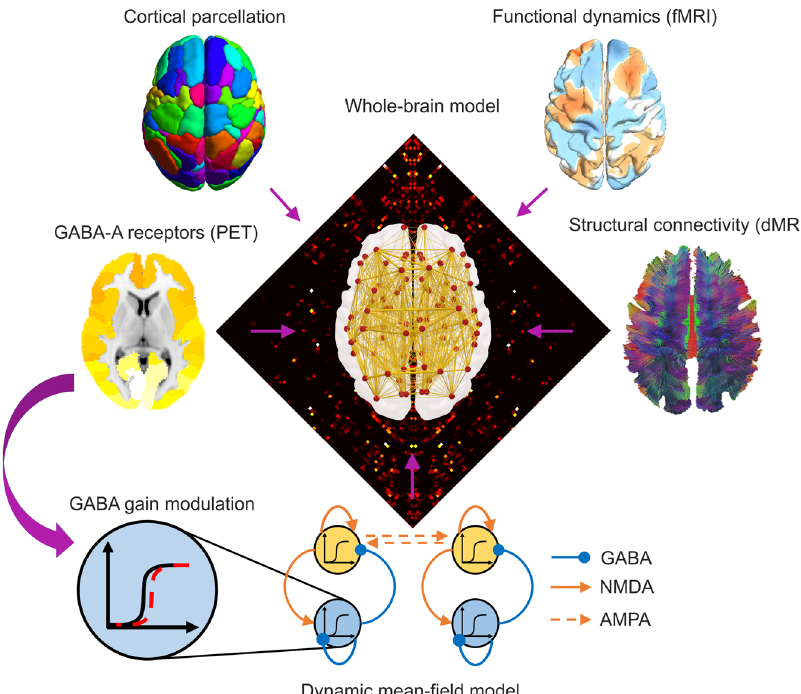
Fig. 1 Overview of whole-brain computational model incorporating multimodal neuroimaging data. Based on a cortical parcellation with 68 regions of interest, each node (cortical region) is modelled through a neurophysiologically realistic biophysical model incorporating excitatory (NMDA) as well as inhibitory (GABA) synaptic dynamics. Nodes are connected by structural connectivity (from diffusion MRI) and the model ’ s simulated BOLD signals are fi tted to simulate empirical BOLD signal patterns (from functional MRI). Neurotransmitter information from PET can also be added in the model as modulating the local neuronal gain 89 .